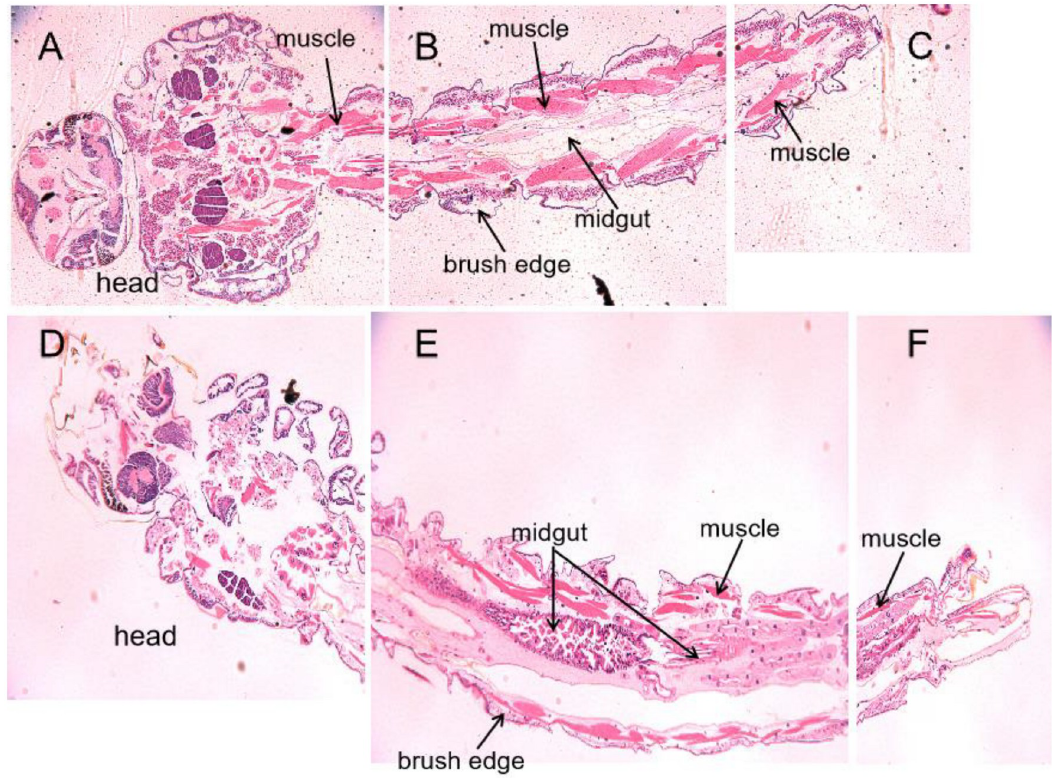
Fig 7. Tissue slices results of Aedes aegypti larvae fed with HR3 RNAi transgenic algae strain HR3-C9. A, B, C. The whole body of the larva fed with none-transgenic C. reinharditii strain CC425; D, E, F: The whole body of the larva fed with pMaa7IR/HR3IR transgenic algae strain HR3-C9. Larvae fed with C. reinhardtii CC425 had intact epidermis, thick muscles, and clear lines. Their midgut was normal and intestinal lumen was intact (A, B, C). The integumentary system of the larvae fed with HR3 RNAi transgenic algae was severely damaged and Their brush edge disappeared. Muscles of them were unevenly distributed, disordered, and some had even dissolved. The midgut were disintegrated with vacuolation of some cells (E, F).